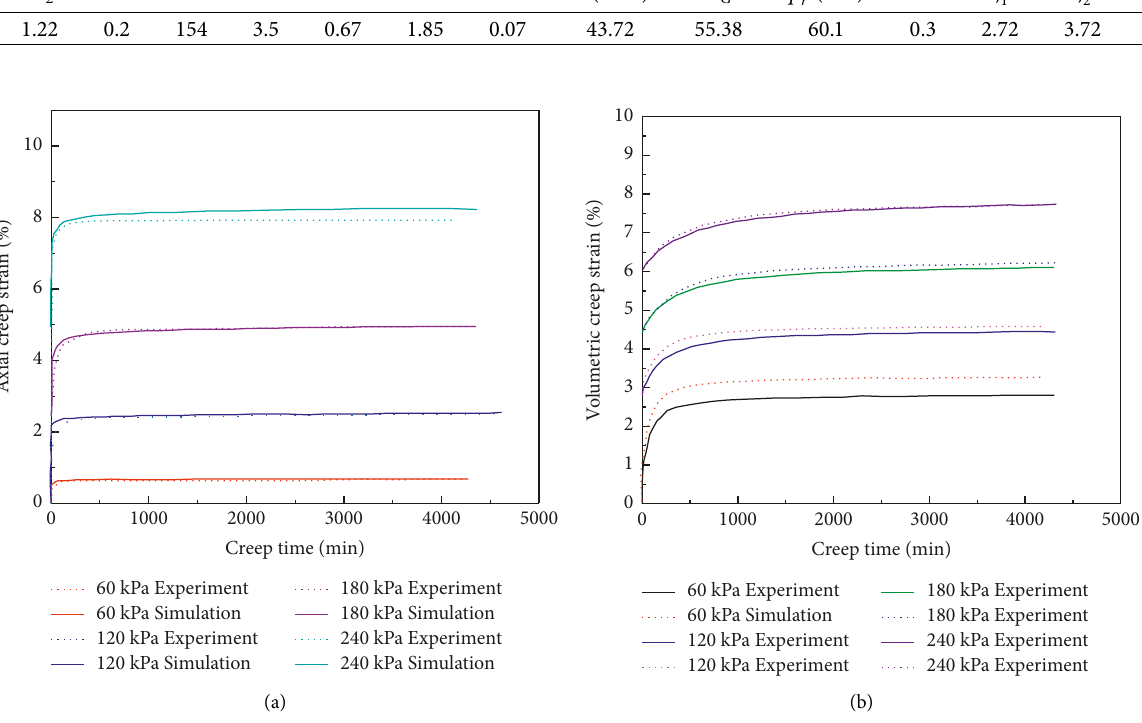
Figure 11: Comparison of the calculated values and the measured values of drained compression creep tests for Tianjin Coastal clay under ′ � 150kPa): (a) axial strains vs. creep time; (b) volumetric strains vs. creep time. different stress levels ( σ 3 Table 2: Fundamental characteristic indexes of the Shantou dredger fill.